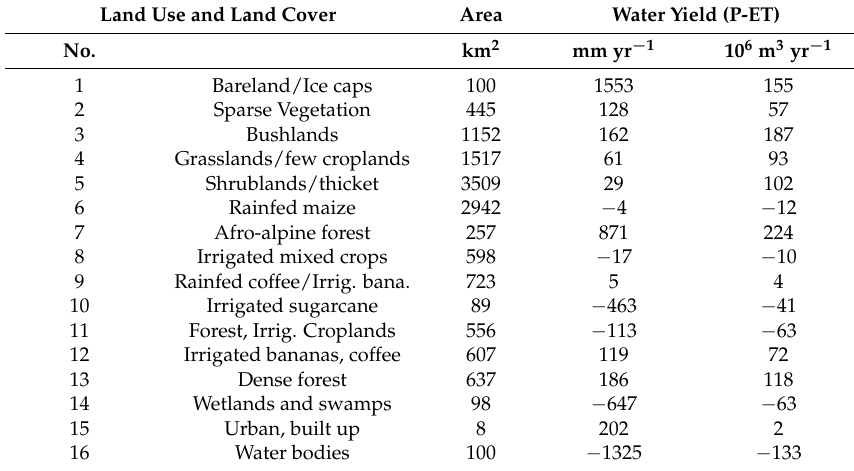
Figure 3. Frequency distribution of the estimated annual mean biomass, from the bootstrap, at 95% confidence limits for the selected land-use types in the Upper Pangani River Basin, for the period of 2008–2010. Table 5. The water yields for various land use and land cover (LULC) types in the Upper Pangani River Basin, for the period of